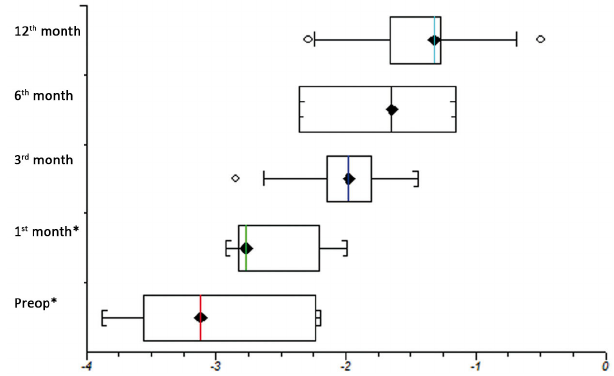
Fig. 4 - Evolution of z-scores for height/age (HAZ) in cardiac patients with HAZ in the preoperative period which was below the normal pattern of development. Analysis of variance with P=0.001. (*) HAZ was significantly lower when compared with the general population’s in the preoperative period and in the first